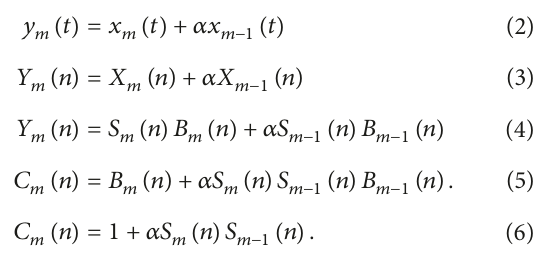
Figure 6: Relation between direct and delay waves ( 𝜏 = 300